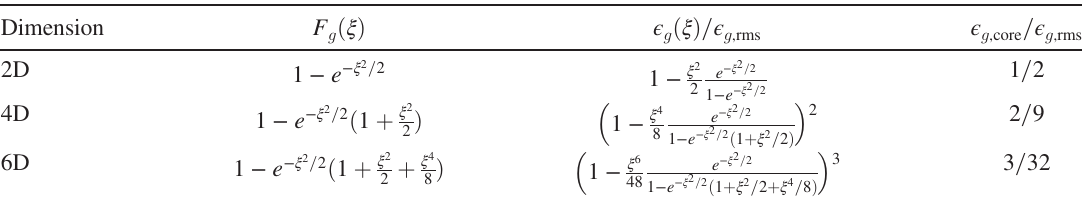
TABLE IV. Analytical expressions of the cumulative density function, F 2D, 4D and 6D Gaussian distribution characterized by a rms emittance ϵ emittance is also